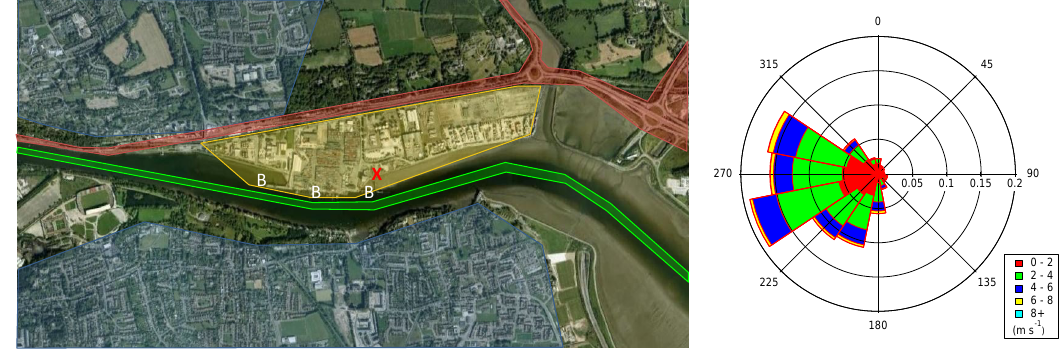
Fig. 1. Left panel: map of sampling site and surrounding area. Cork city lies 3km to the west. The site (X) is positioned to the northeast of the nearby shipping berths (B) in the Port of Cork (yellow), surrounded by residential areas (blue), a shipping lane (green) and a main road (red). Right panel: Windrose for 7–28 August